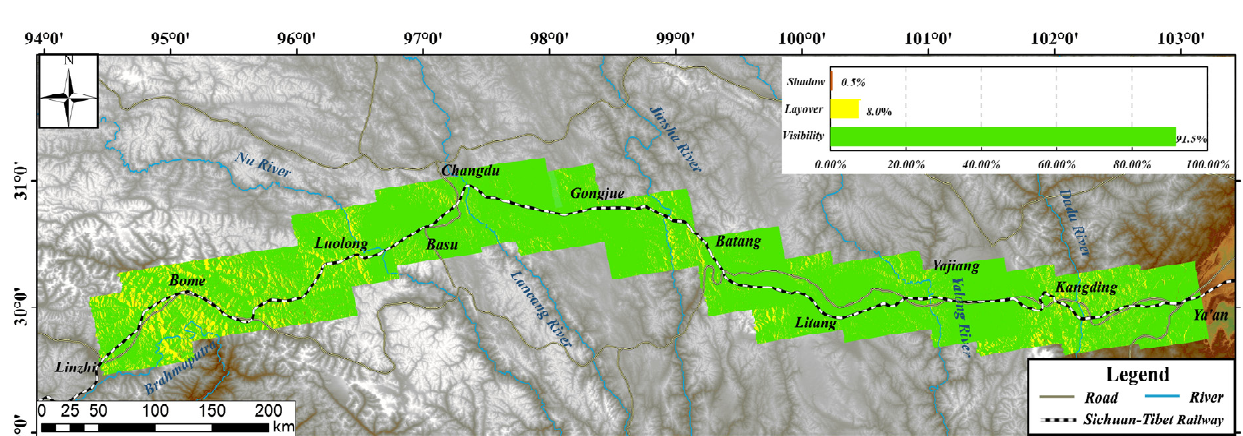
Figure 3. Visibility analysis map. Green indicates the visibility area, yellow indicates the layover area, and brown indicates the shadow area.